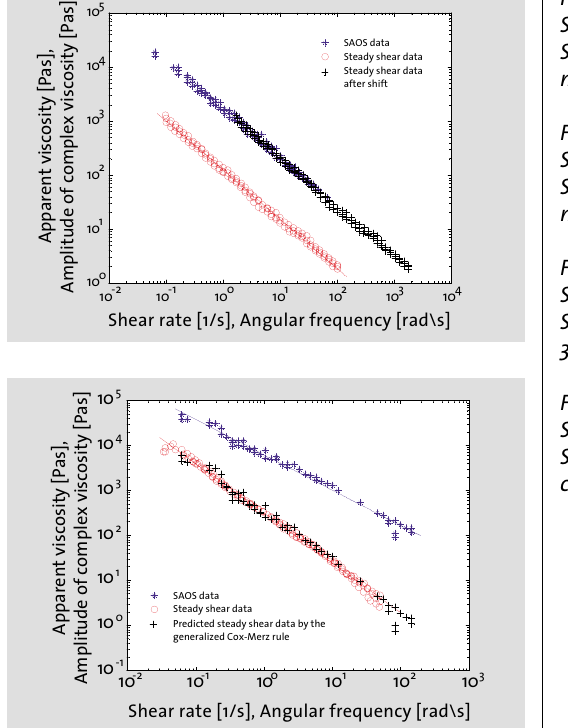
Shear rate [1/s], Angular frequency [rad\s]